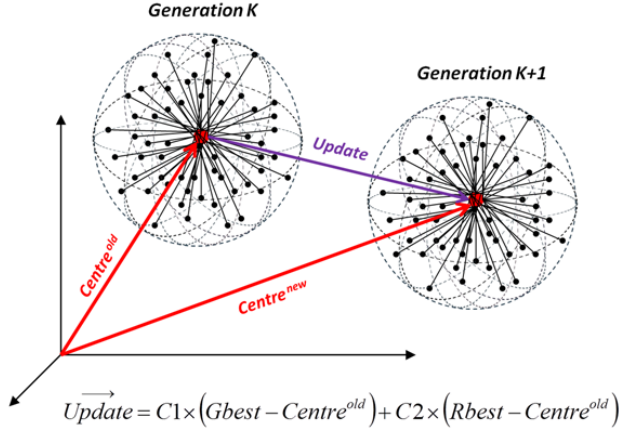
Figure 7. Updating the centre point using an update vector [39].